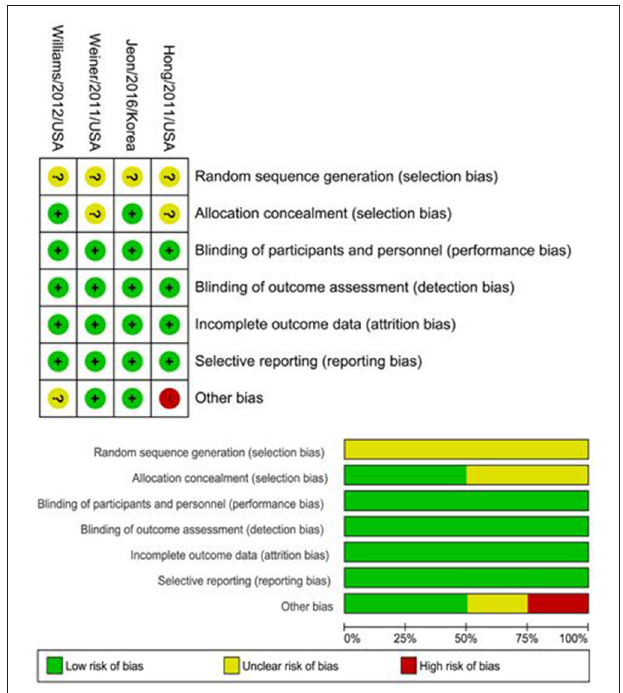
FIGURE 2 | Summary of risk of bias assessment according to Cochrane collaboration tool.